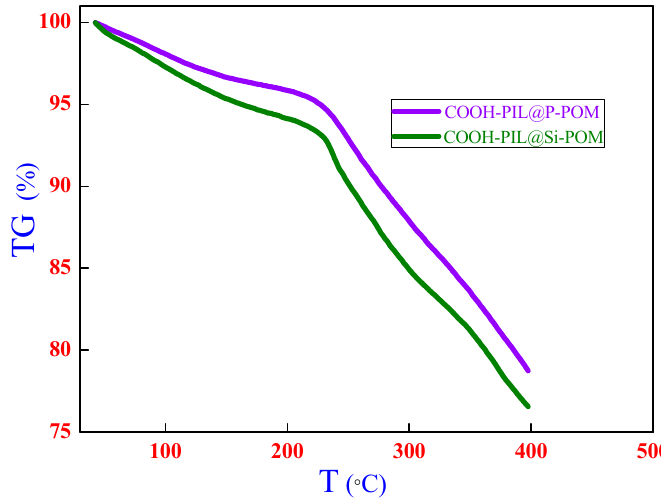
Figure 2. TG patterns of COOH-PIL@P-POM and COOH-PIL@Si-POM. The viscosity average FW of 23,000.